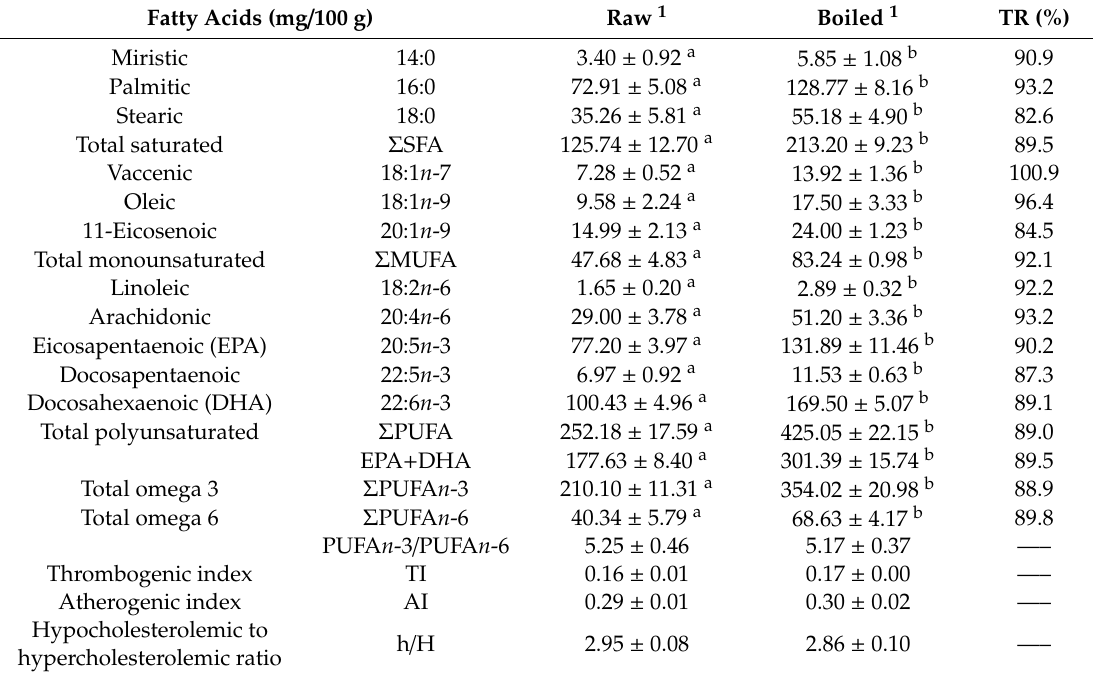
Table 4. Fatty acids composition (most abundant) and true retention (TR) of common